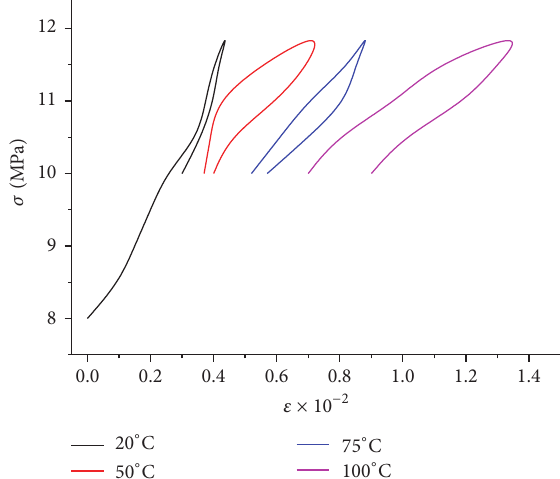
Figure 6: Triaxial stress-strain curves of coal sample 1 # at different temperatures.